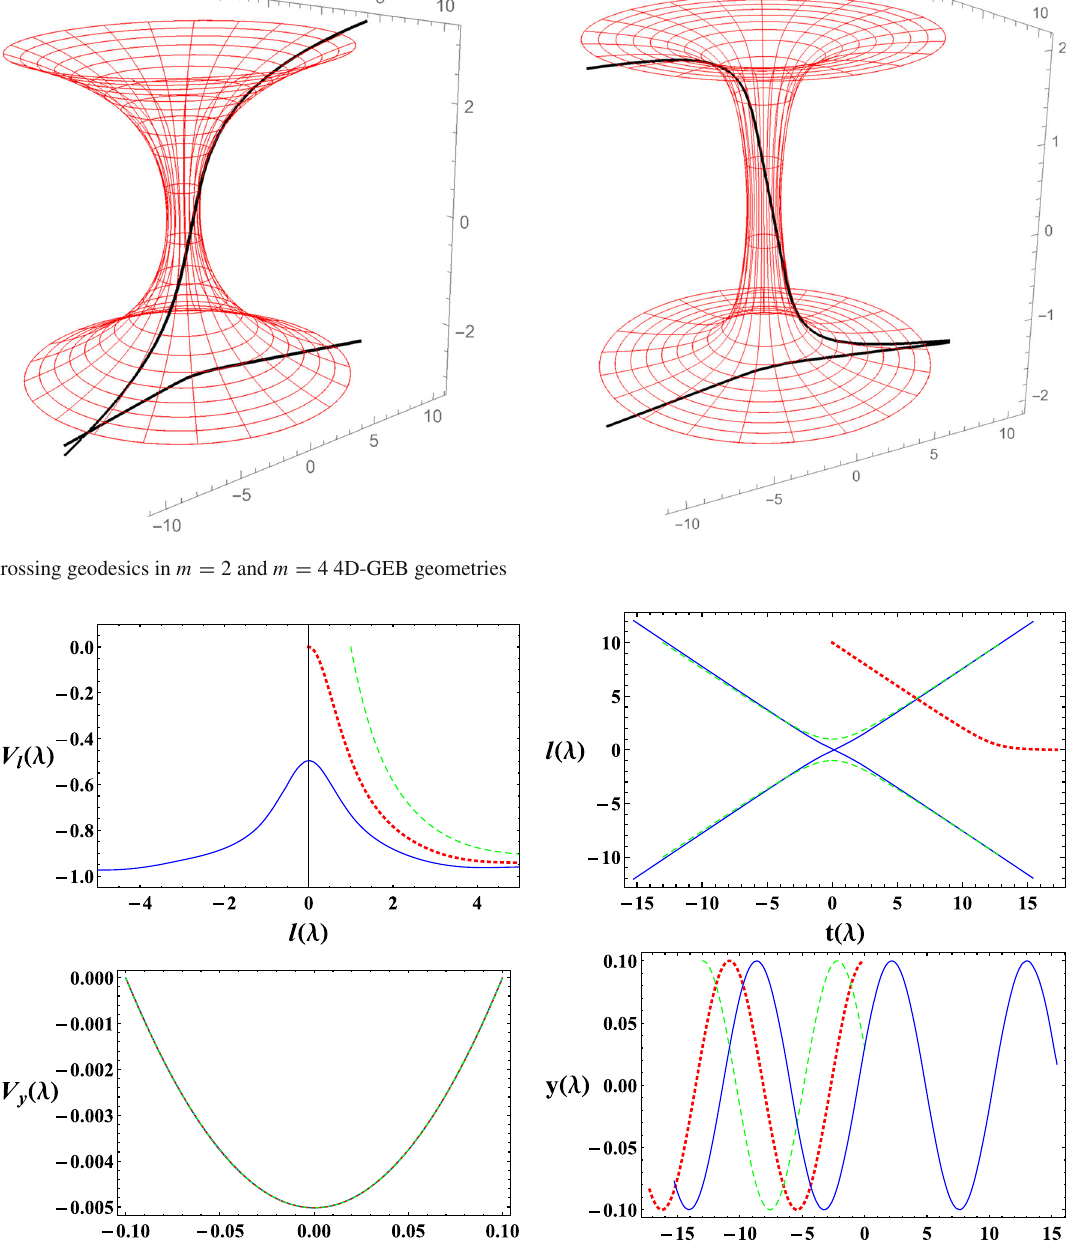
5D warped thick braneworld background and showed that corresponding energy conditions are satisfied. In this